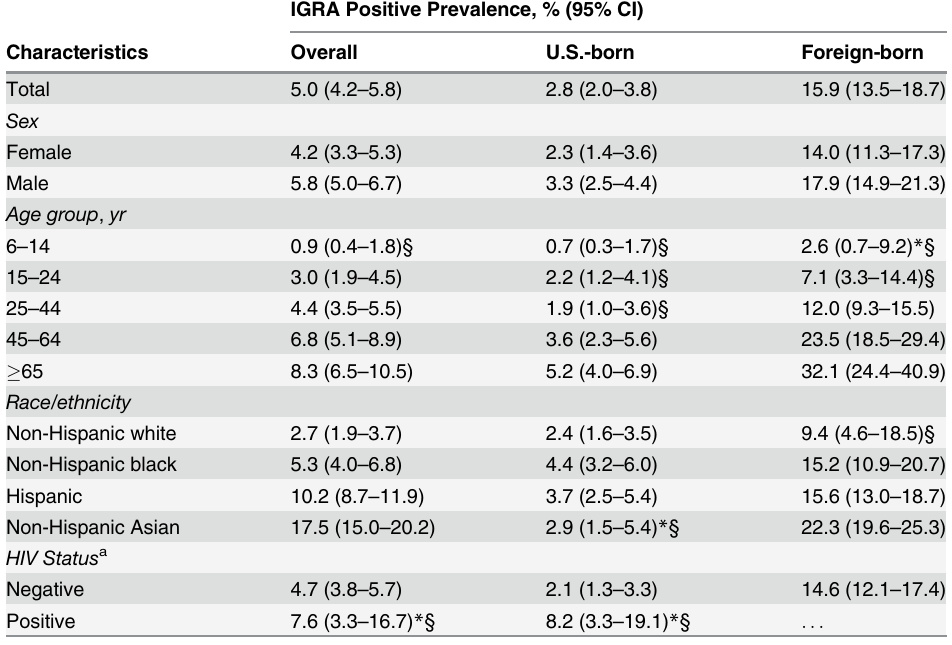
Table 4. Interferon Gamma Release Assay Positive Prevalence in the Civilian, Noninstitutionalized U. S. Population, Ages 6+, 2011 –